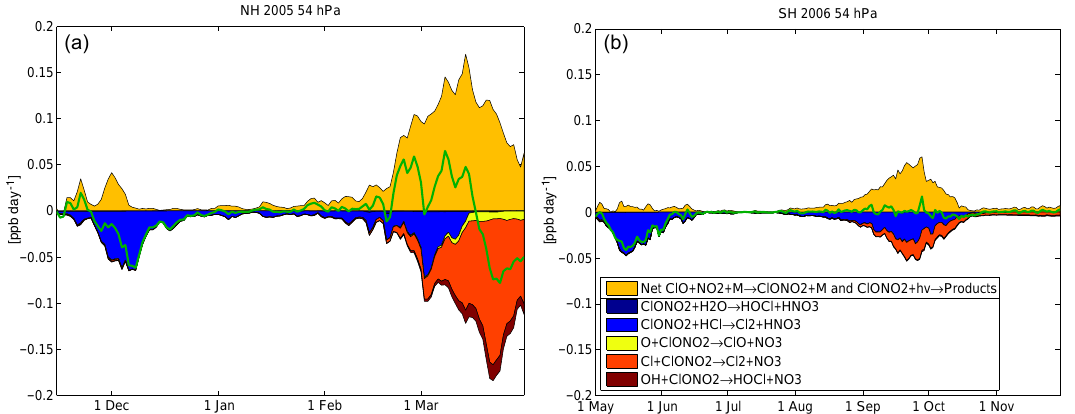
Figure 17. Vortex-averaged chemical reaction rates involving ClONO 2 for the Arctic winter 2004–2005 (a) and the Antarctic winter 2006 (b) at 54hPa. In contrast to Fig. 16, the net production rate of the fast cycle ClONO 2 + hν → products / ClO + NO 2 + M → ClONO 2 + M is shown. This cycle is separated by a line in the legend from the loss reactions. The green line shows the net change of ClONO 2 by chemistry. Reactions with rates which cannot be distinguished from the zero line at plot resolution are not